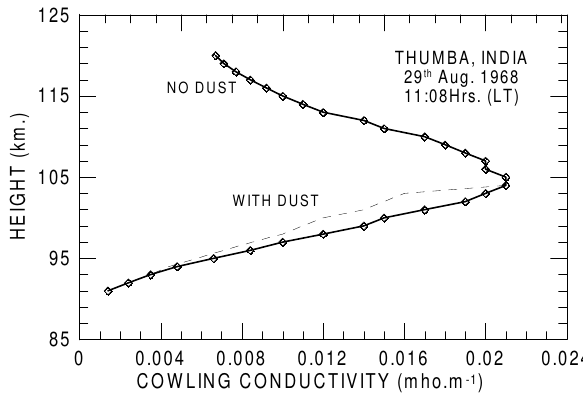
Fig. 8. Variation in the daily range of the horizontal component of the geomagnetic field at Trivandrum, India on quiet days during the month of November, averaged for the years 1994, 1997 and 1998. Vertical lines in the figure show the data spread. Also indicated in the figure is the Leonid meteor shower